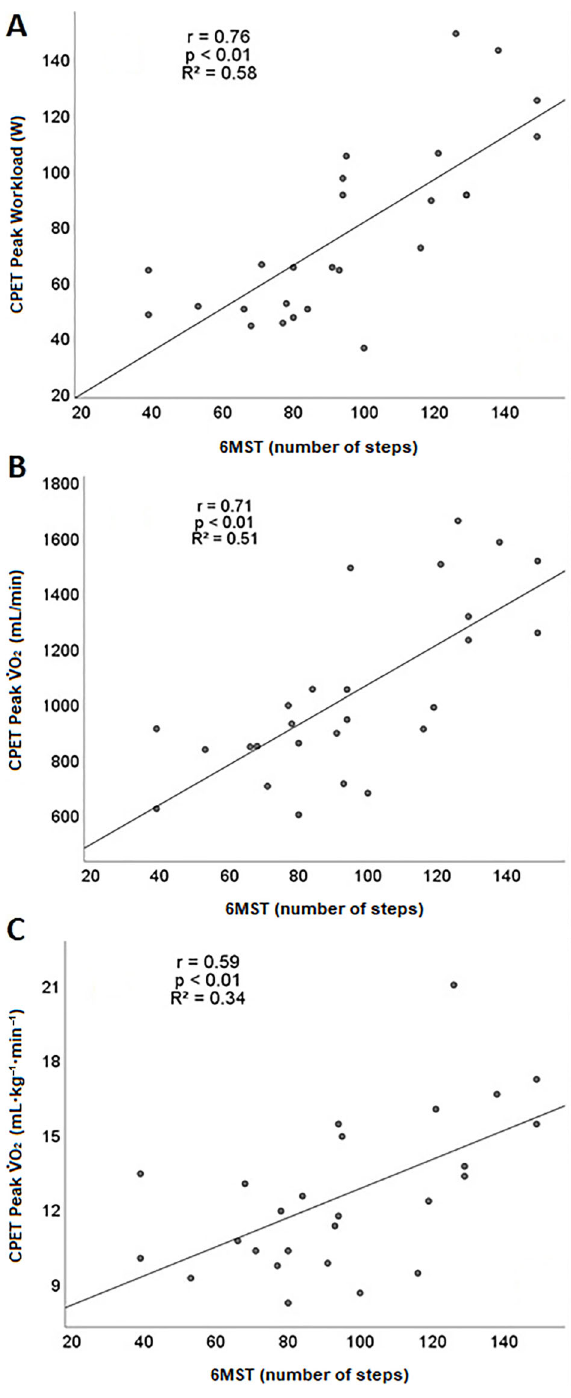
Figure 3. Correlations between ( A ) peak workload on cardiopul- monary exercise test (CPET) and six-minute step test (6MST) number of steps, ( B ) CPET peak V ̇ O 2 (mL/min) and 6MST number of steps, and ( C ) CPET peak V ̇ O 2 (mL (cid:3) kg – 1 (cid:3) min – 1 ) and 6MST number of steps.